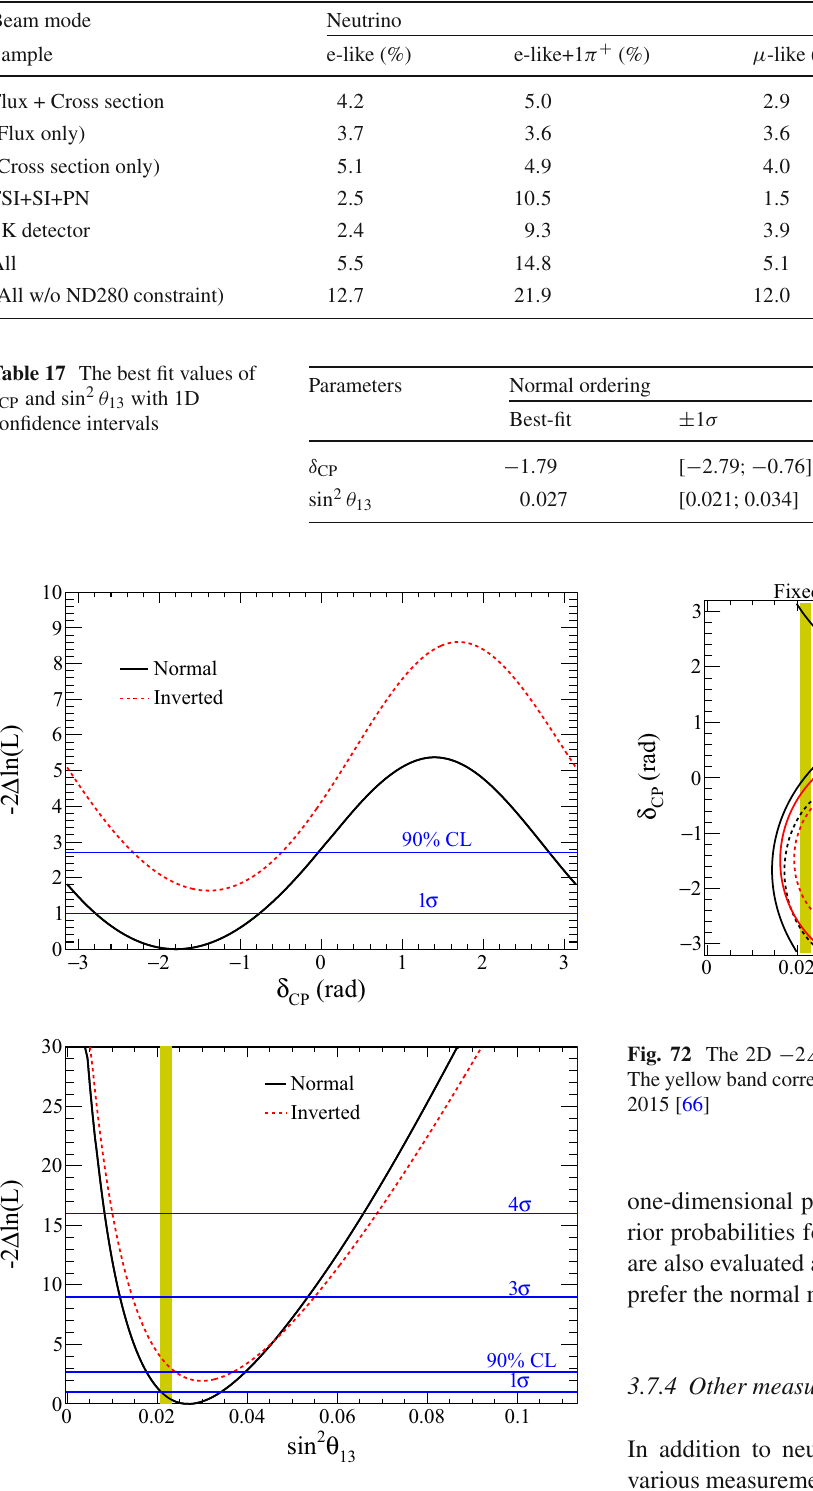
Table 16 The systematic uncertainties on the predicted event rates ( δ N / N ) at SK. FSI stands for “Final State Interactions”, SI is “Secondary Interactions” and PN is “Photo-Nuclear effect” (Data from [68])